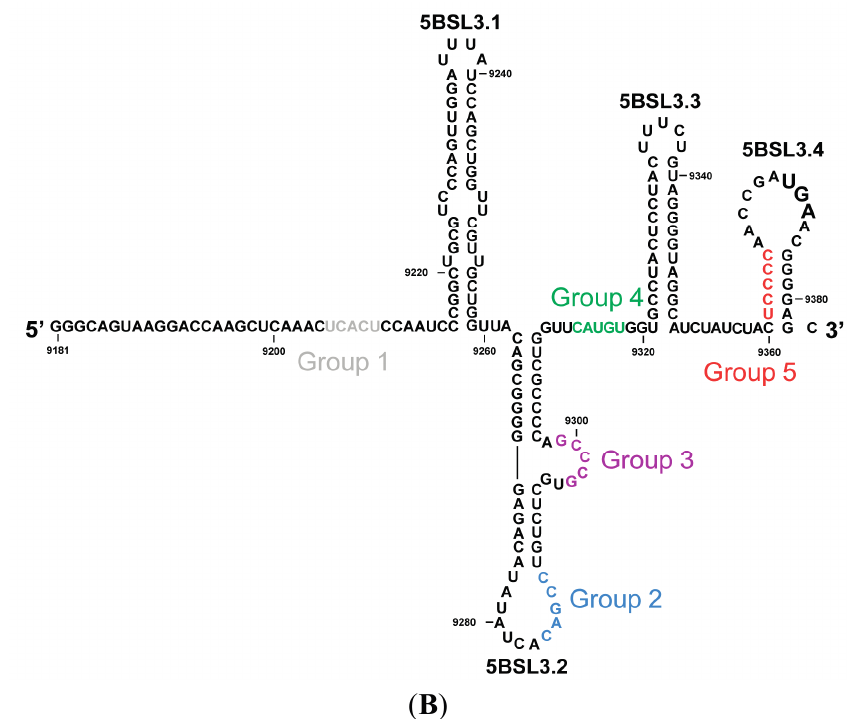
Figure 1. Structural organization of the HCV RNA genome. ( A ) Detailed diagram of the secondary structure proposed for the 5 ′ and 3 ′ ends of the HCV RNA including functional domains involved in the establishment of long-range RNA-RNA interactions. The minimal region required for the IRES activity is indicated. The architecture of the 3 ′ end of the viral genomic RNA is organized into two well-defined structural elements: the CRE region and the 3 ′ X-tail. Translation start and stop codons are indicated by arrows. The grey solid lines identify long-distance RNA-RNA contacts involving the IRES, the CRE, the Alt, and the 3 ′ X-tail regions. HV, hypervariable region; ORF, open reading frame; ( B ) The sequence and the secondary structure for the HCV CRE region. Nucleotides complementary to the consensus sequences of the selected aptamers are indicated by different colors according to the consensus group [34]. Numbers refer to the nucleotide positions of the HCV Con1 isolate (GenBank accession number